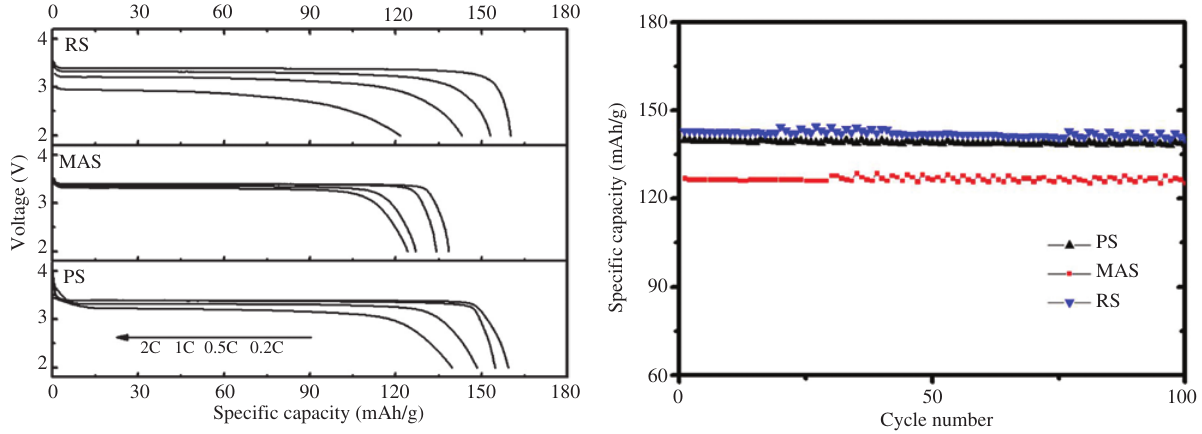
Figure 4: Specific capacity at different rates (left) and the cycling performance at 1 C rate (right) of